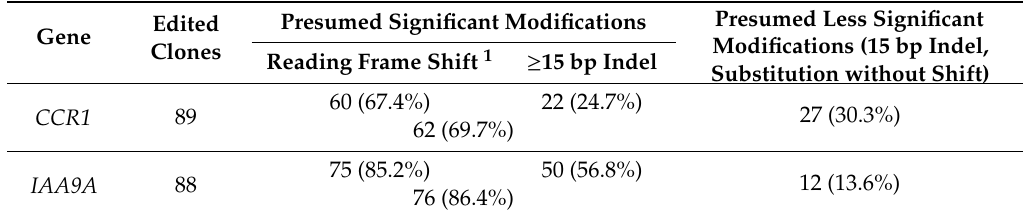
Table 3. Majority of altered alleles introduced significant modifications at the protein level.